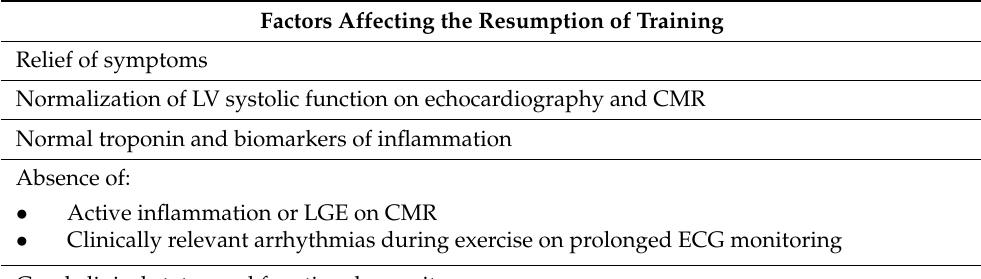
Table 5. Factors affecting the resumption of training (based on [88,89]).